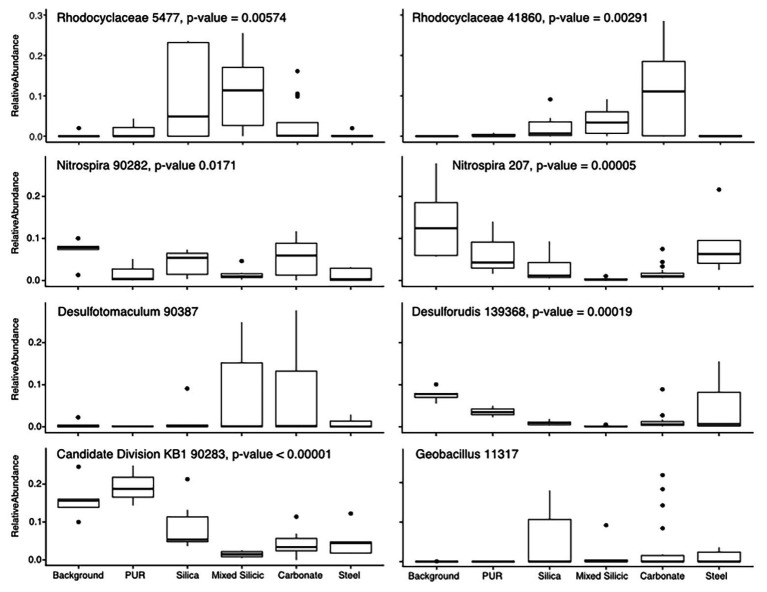
Tukey-style box and whiskers plot showing the average relative abundance of similarity percentage (SIMPER)-identified important taxa by substrate group. For each grouping of samples, the box represents the upper and lower quartiles surrounding the median (line in the box). Whiskers represent the remaining spread of the data, apart from outlying data points (defined as points further from the median than 1.5× Interquartile Range). We isolated 16S data from Incubations 1, 2, and 5 (since they are least impacted by the organic substrate addition) and identified the eight most common OTUs to appear in SIMPER pairwise analysis of substrates (ANOSIM by substrate: R = 0.3863, p = 0.001). The relative abundances for these OTUs were averaged across the three Incubations in order to analyze mineral preference across the microbial community. “Background” samples include bailed filtered and unfiltered water (n = 5); “PUR” indicates polyurethane foam block samples (n = 3); “Carbonates” include calcite, dolomite, and HVD samples (n = 18); “Silica” indicates glass wool samples (n = 6); “Mixed” indicates MS lithology (tuff and lake sediments; n = 6); “Steel” indicates low carbon steel ball bearings (n = 5). Plots are additionally labeled with the one-way ANOVA value of p if significant (p < 0.05). The lack of significance for the Desulfotomaculum and Geobacillus OTUs was indicative of the fact that the Desulfotomaculum population crashed after Incubation 1 and that the Geobacillus was infrequently found on minerals, but that, when present, it was often in high abundance, supporting the idea that this organism is infrequently detected but typically detected at high abundance.